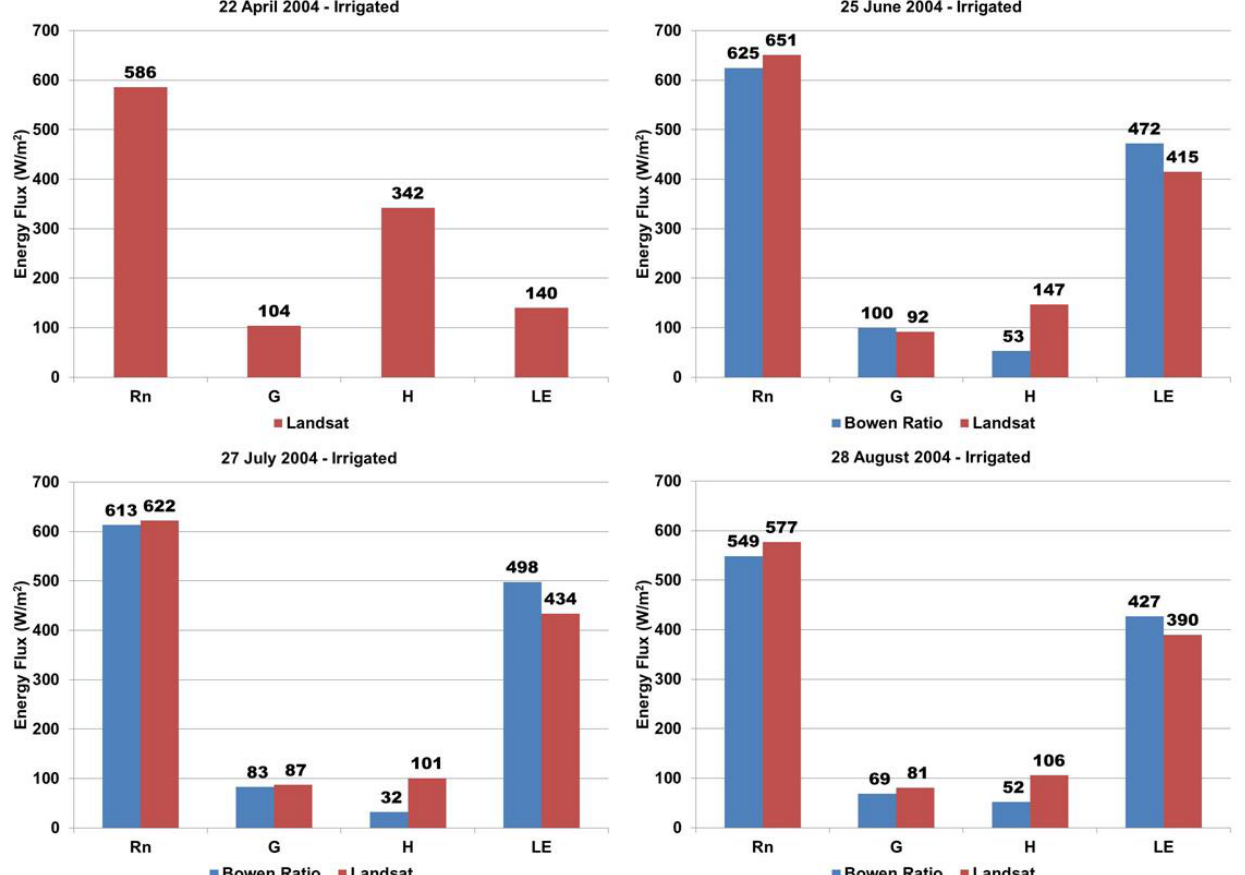
Figure 9. Results of reconstructed ET algorithm calculation for components of the energy balance from four Landsat scenes for irrigated site (KL04). (Note: An insufficient number of sensors were operational at this station on 22 April 2004 to compute energy